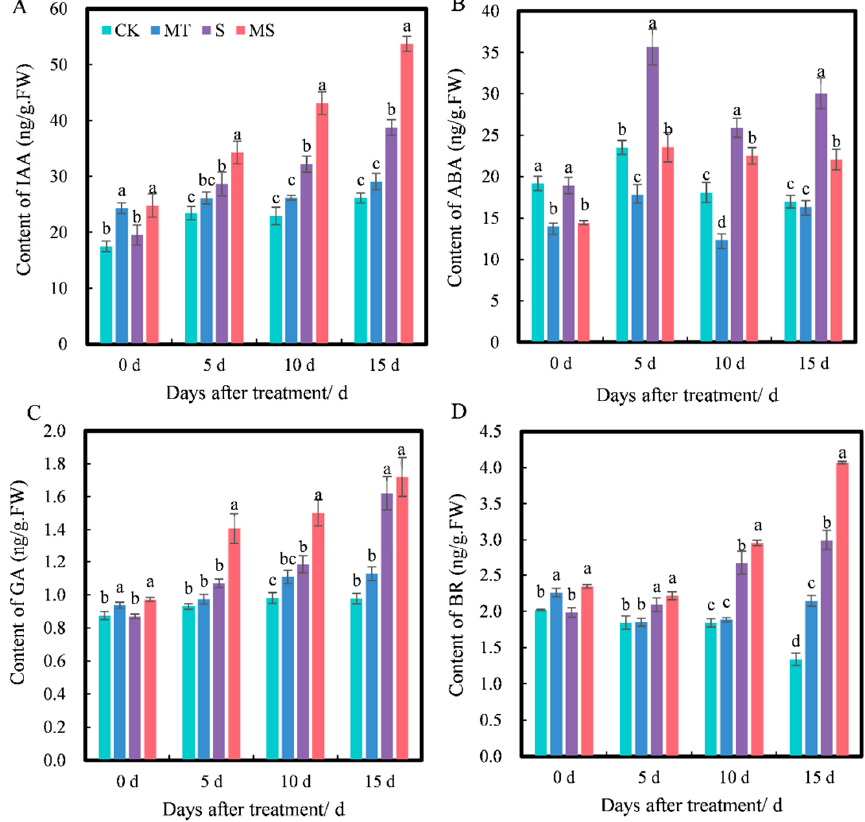
Figure 5. Effects of exogenous melatonin on ( A ) auxin (IAA), ( B ) abscisic acid (ABA), ( C ) gibberellin (GA) and ( D ) brassinosteroid (BR) contents of cotton seedling roots under salt stress. Different lowercase letters indicate significant differences among treatments at the same timepoint ( p < 0.05). CK, control treatment; MT, melatonin treatment; S, NaCl treatment; MS, combined melatonin and NaCl treatment.